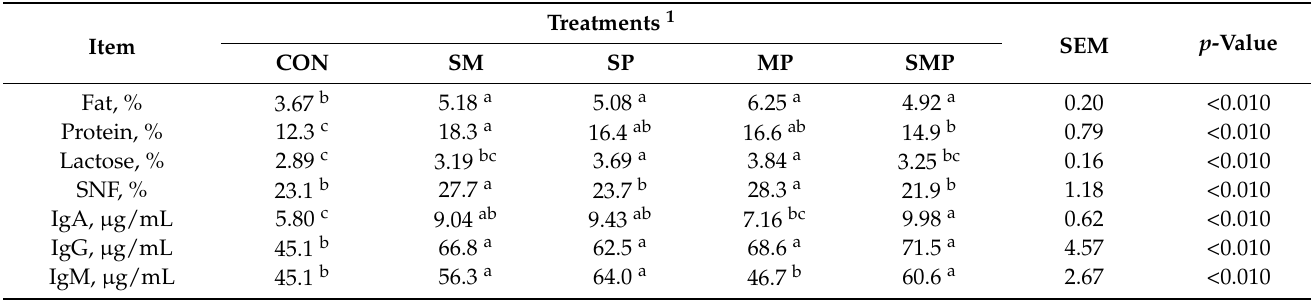
Table 4. Effects of supplementing the diets with different combinations of SB, MCFAs, and omega − 3 PUFA on the colostrum composition of sows.